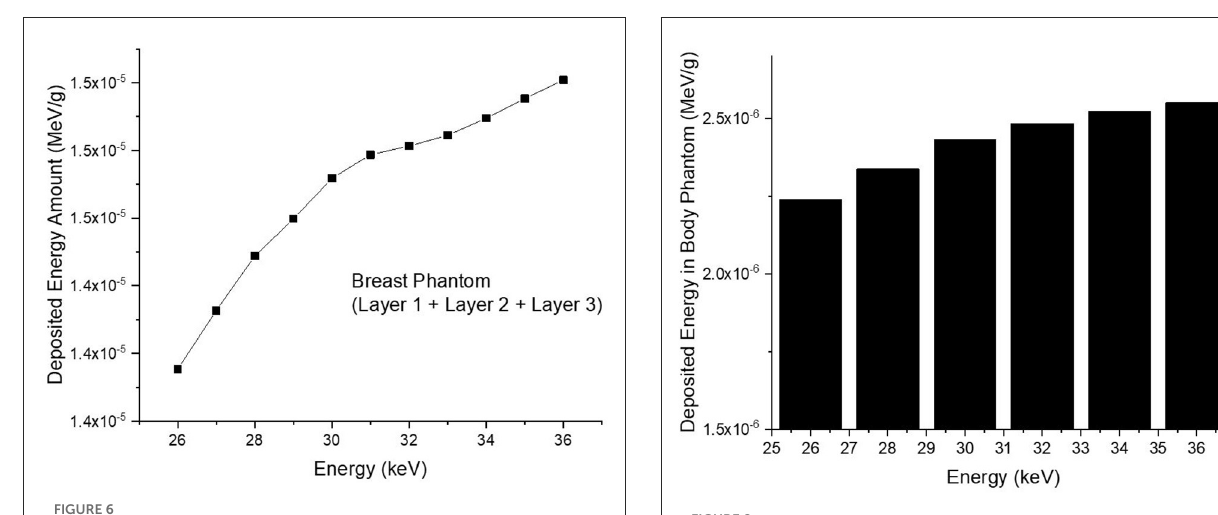
FIGURE8 Variation of deposited energy amount (%) in modeled body